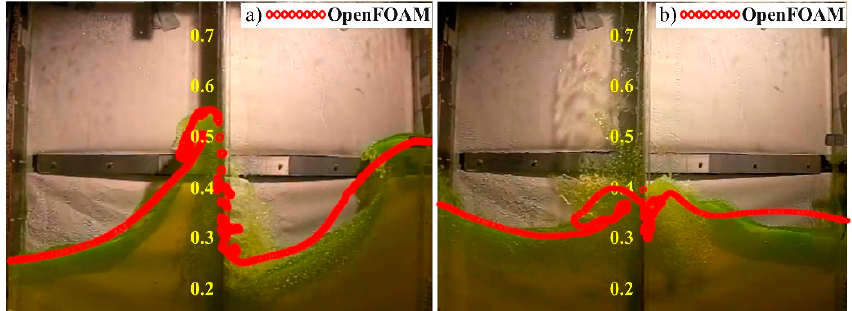
Figure 4. Flow motion through the vertical slot baffle in Faltinsen’s experimental tests [33], τ is the porosity of the baffle, ( a ) τ = 0.085, ω / ω 1 = 1.328, Time = 14 s, ( b ) τ = 0.527, ω / ω 1 = 0.96, Time = 46 s.